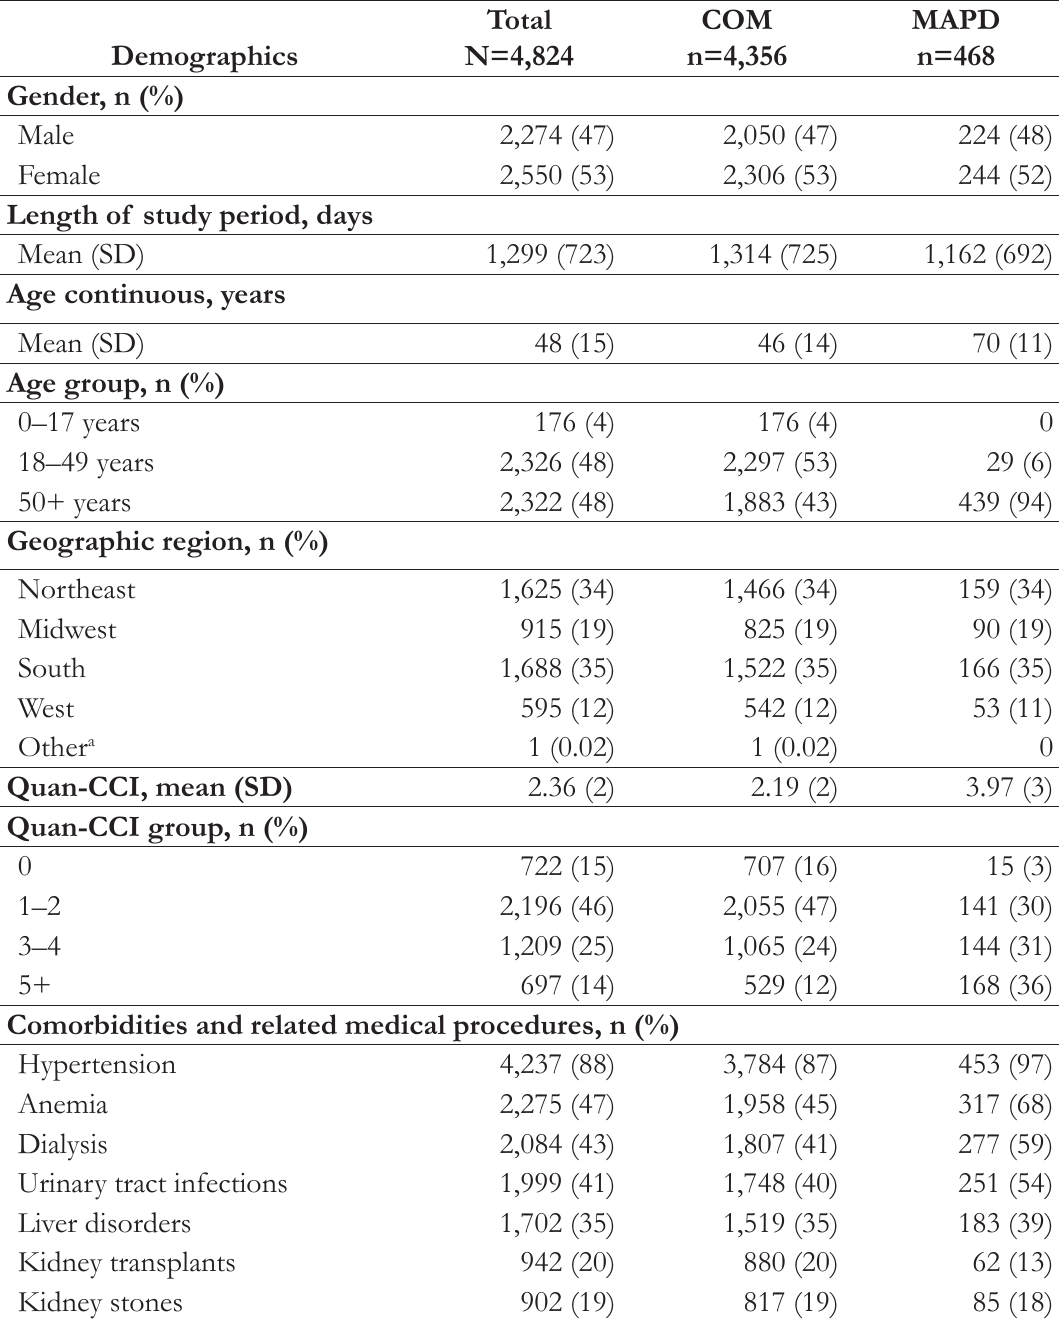
Table 1. Baseline Patient Demographics and Clinical Characteristics